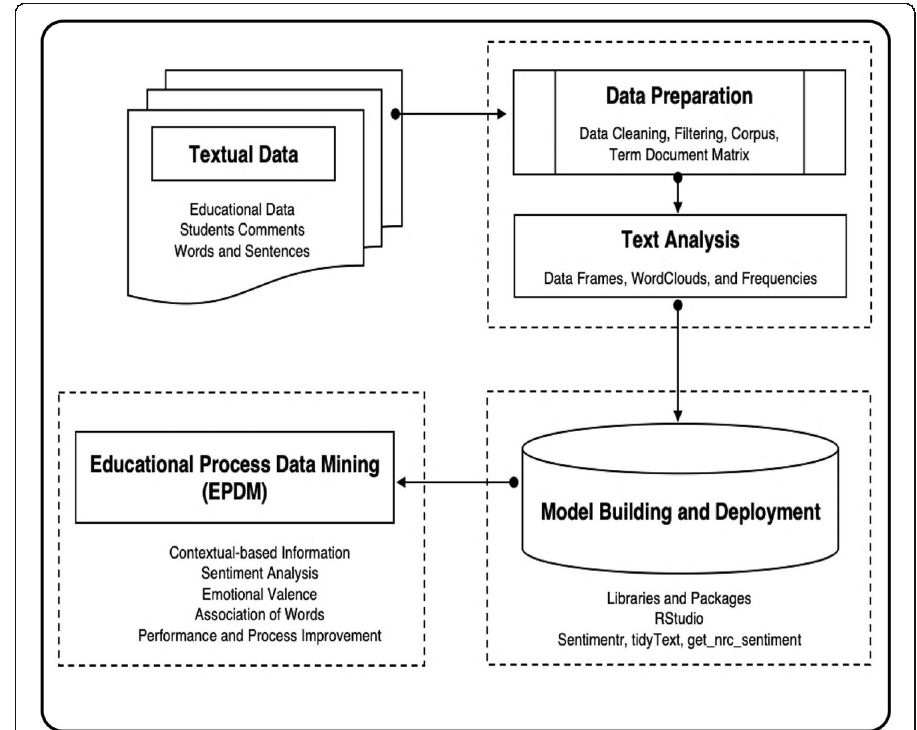
Fig. 1 Educational Process Data Mining (EPDM)